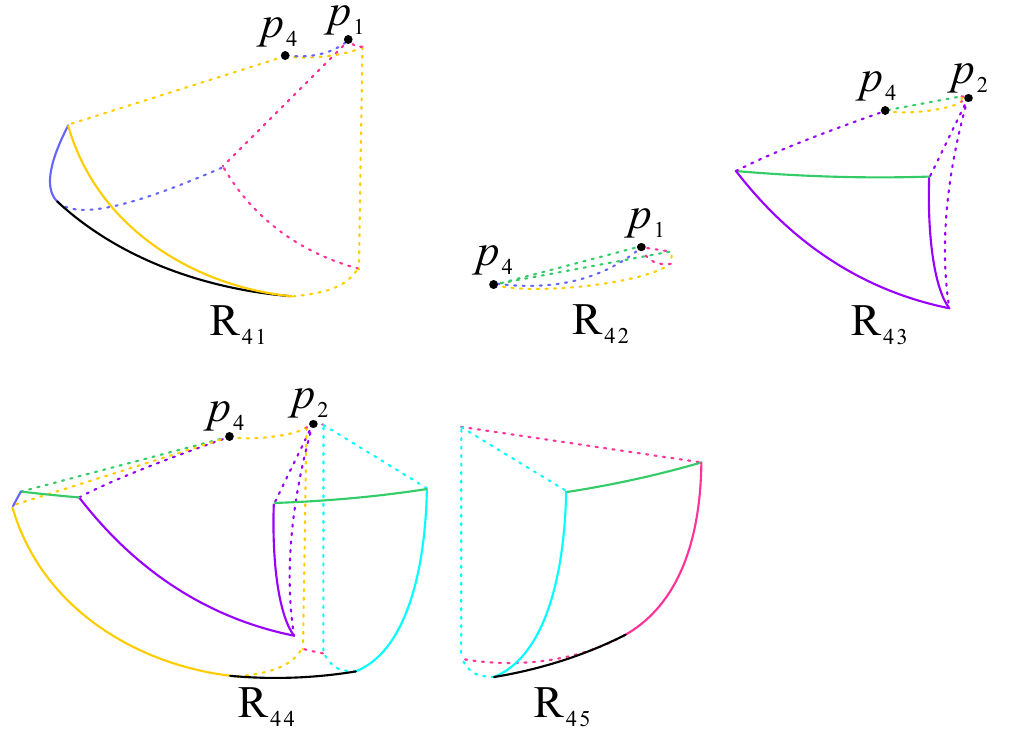
Figure 9. The region R 4 is divided into five subregions by the five planes y = 0, z = 0, Ω ( m ) = 0, b 2 = 0, and b 3 = 0, and one surface b 1 = 0. For subregion R 41 , its front part is limited by b 2 = 0, its back is bounded by y = 0 and Ω ( m ) = 0, and its bottom and top are restricted by Poincaré sphere and b 3 = 0, respectively. The trajectories in subregion R 41 are monotone increasing in the positive x axis, and decreasing in the positive y and z axes. So these trajectories stem from subregions R 42 and R 44 and destine for the infinite equilibrium points in y = 0 limited to R 41 . The front of subregion R 42 is restricted by b 2 = 0, the back is bounded by y = 0 and Ω ( m ) = 0, the top is confined by z = 0, and the bottom is limited by b = 0. The 3